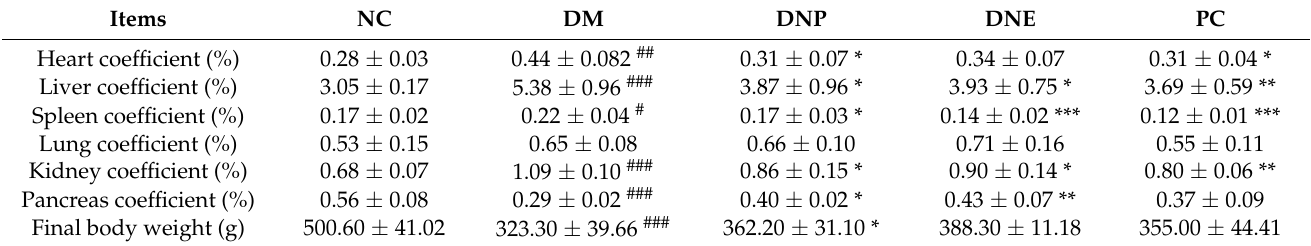
Table 2. Effects of D. nobile on the organ coefficients of rats.